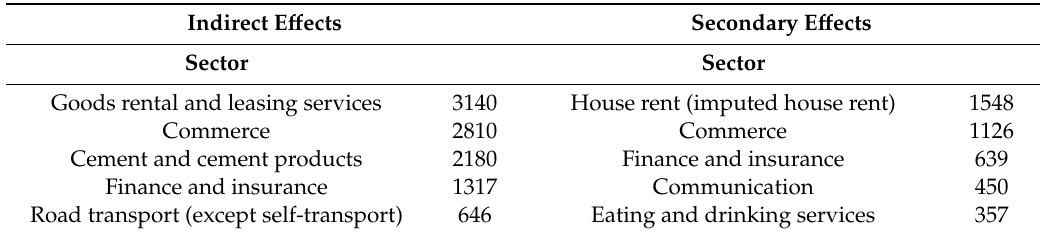
Table 8. The top five sectors for the indirect and secondary e ff ects of constructing a concrete check dam (unit is thousand yen).